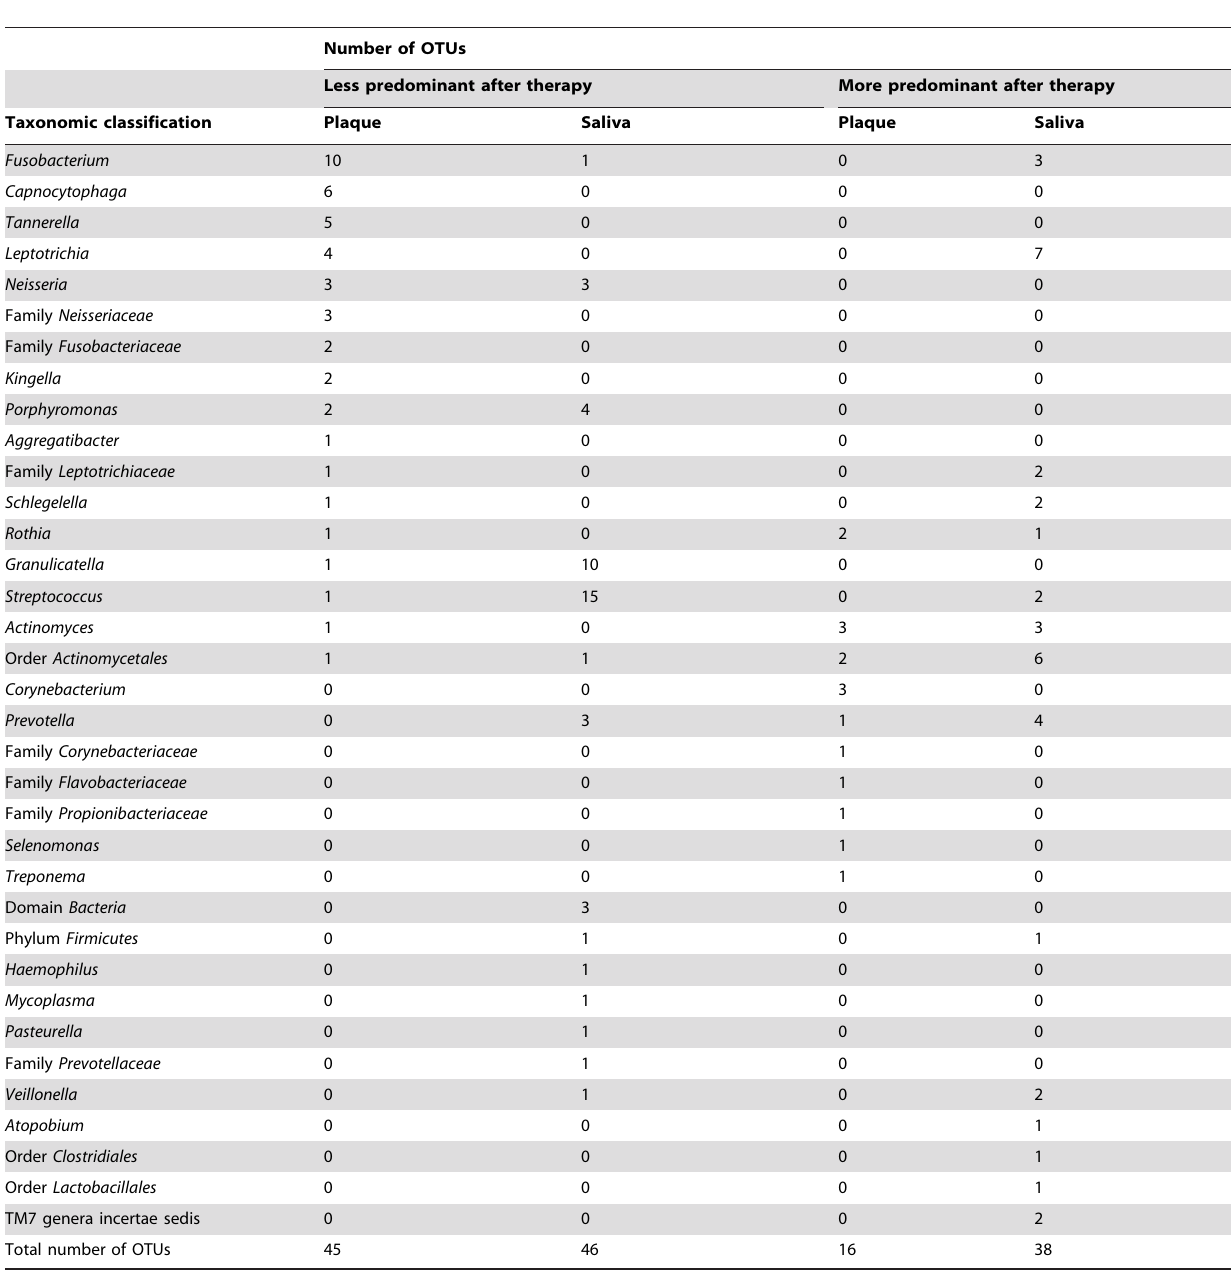
Table 6. Taxonomic classification of operational taxonomic units (OTUs) whose relative abundances in the microbiotae were significantly altered after periodontal